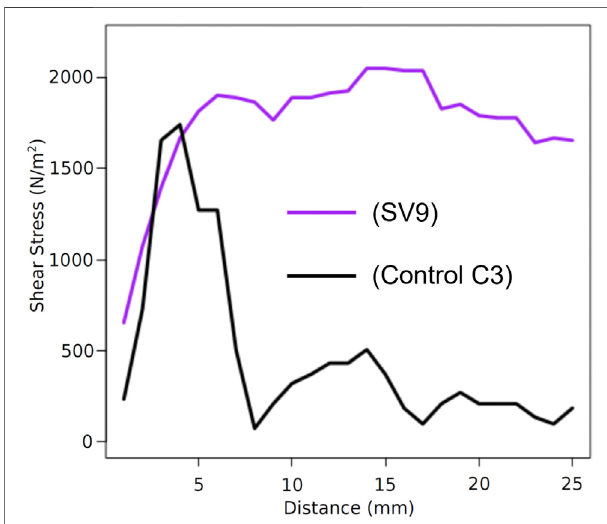
FIGURE6| Comparison betweenshearcurvesproducedfromacoreof control trial C3 and SV3 ( S. virginicus at 9 weeks maturity).